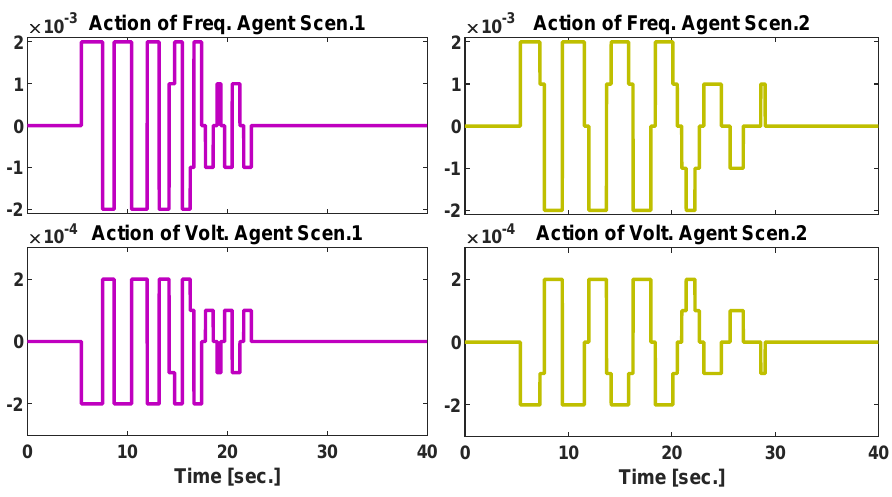
Figure 20. Actions selected by the RL frequency/voltage agents in different scenarios.